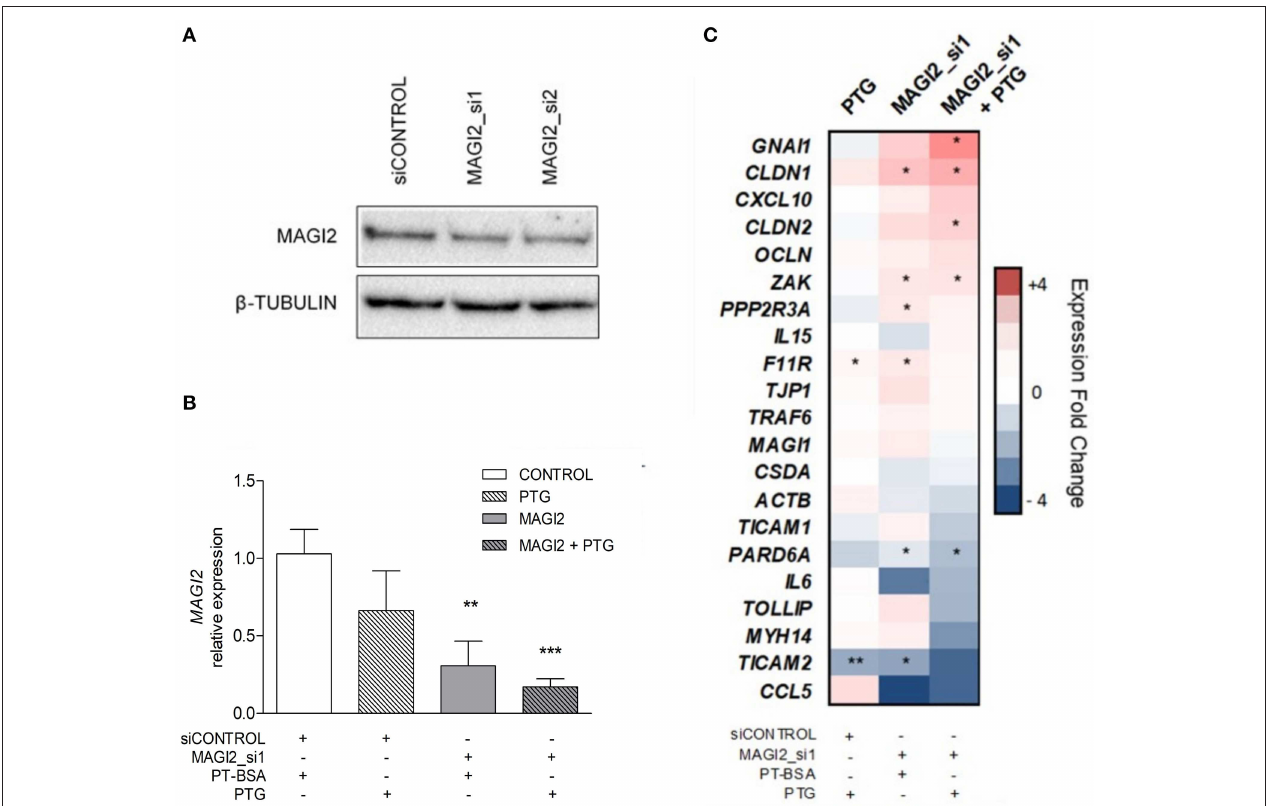
FIGURE 3 | Effects of MAGI2 silencing and gliadin on the expression of a TJ-related genes in C2BBe1 intestinal cells. (A) Western blot of MAGI2 protein upon silencing in C2BBe1 cells. (B) Quantification of MAGI2 protein levels under different cell treatments, relative to control cells (transfected with control siRNA and incubated with PT-BSA). Mean and standard deviation are shown ( n = 3). (C) Heat map of candidate gene expression in different conditions; PTG stimulation, siRNA mediated MAGI2 silencing (MAGI2_si1) and PTG stimulation of MAGI2_si1 cells. Expression levels are shown as fold-change relative to the average of control samples (silenced with a control siRNA and incubated with PT-BSA). Columns represent treatment categories and lines candidate genes (*0.01 < p < 0.05; **0.001 < p < 0.01; *** p < 0.001).